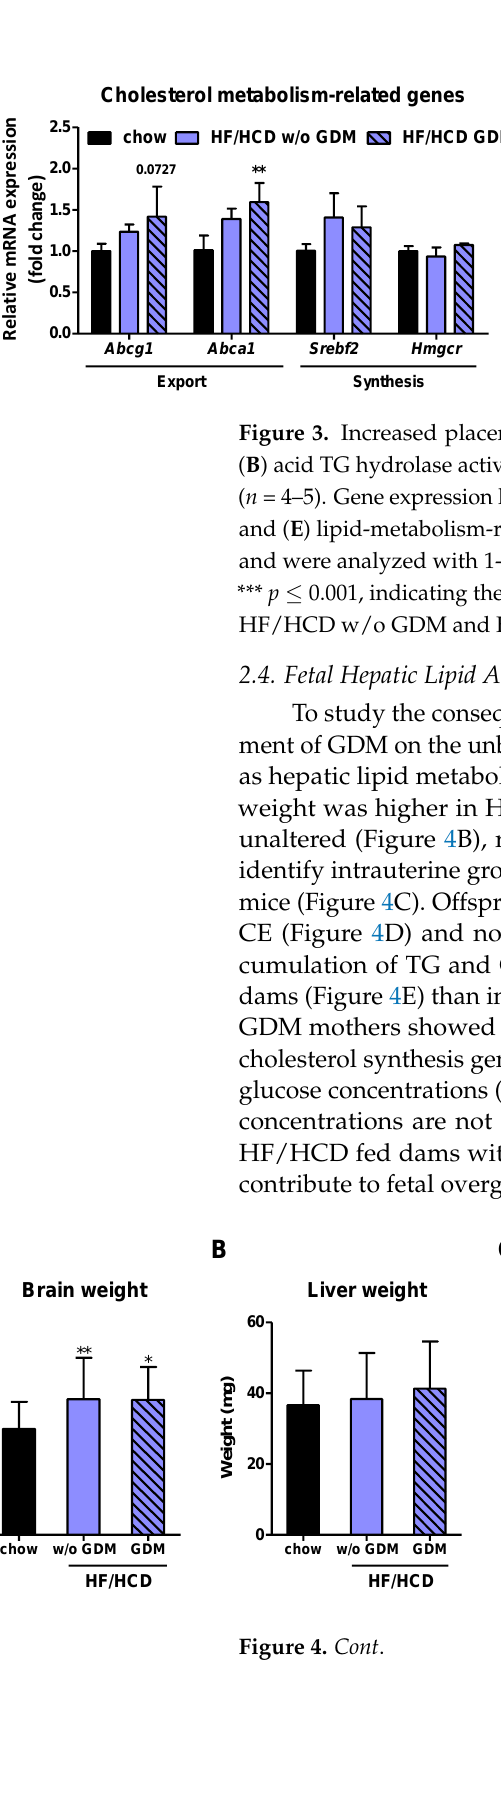
Figure 4. Elevated plasma and hepatic lipid concentrations in offspring of HF/HCD-fed dams with- out and with GDM. ( A ) Fetal brain weight, ( B ) liver weight, and ( C ) brain-to-liver ratio. Fetal ( D ) pooled plasma lipid concentrations ( n = 3 chow, 6 HF/HCD w/o GDM, 3 HF/HCD GDM), ( E ) hepatic lipid content ( n = 5), and ( F ) hepatic gene expression of lipid metabolism-related genes ( n = 4). ( G ) Plasma glucose concentrations in pooled fetal plasma samples ( n = 3 chow, 6 HF/HCD w/o GDM, 3 HF/HCD GDM). Data represent mean + SD and were analyzed with 1-way ANOVA followed by Bonferroni post hoc test. * p < 0.05, ** p ≤ 0.01, *** p ≤ 0.001 indicates the comparison to the chow condition. 3. Discussion GDM is one of the most common pregnancy disorders worldwide. In 2021, the prev- alence of GDM in Europe and North America was 15% and 20.7%, respectively [31]. The mouse model we used to study placental lipid hydrolases in GDM is based on the two major risk factors for the development of GDM: advanced maternal age and over- weight/obesity [2 – 4]. To investigate the effects of pre-existing or pregnancy-related ma- ternal obesity, mice were fed a diet enriched with fat and cholesterol prior to and during pregnancy. The prolonged glucose clearance in HF/HCD-fed mice already before mating revealed a metabolic change, which was reversed during pregnancy in the HF/HCD group without GDM but remained prolonged in the GDM group. There are conflicting results regarding placental weight in human GDM: Whereas most studies report an increased weight of the placenta (reviewed in [32]), decreased pla- cental weight in diabetic women has also been observed [33]. Thus, the placenta may be both heavier and lighter in GDM. In line with the study from Romero et al. [33], our mu- rine GDM model displayed increased placental efficiency due to smaller placental weight and higher fetal weight. In the present study, we can exclude the possibility of increased fetal size due to smaller litter size [34] in the HF/HCD and GDM groups, as all dams had a similar number of pups per litter, regardless of maternal diet and diabetic condition. In accordance with the reduced placental weight, several structural markers of the placenta, especially for the junctional zone as well as one for the labyrinth, were decreased in the HF/HCD and GDM placentae. A reduced junctional zone in obesity during pregnancy